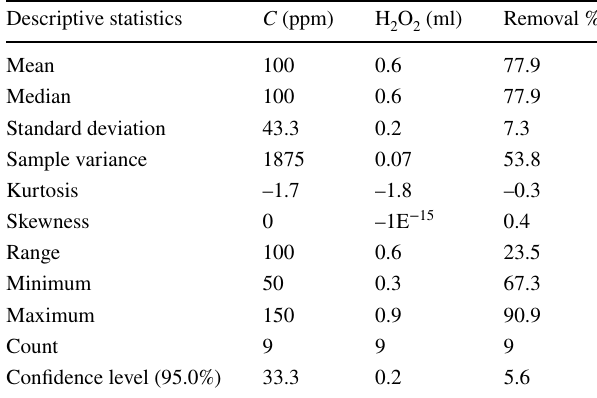
Table 3 Descriptive statistics of the data used for R H t model